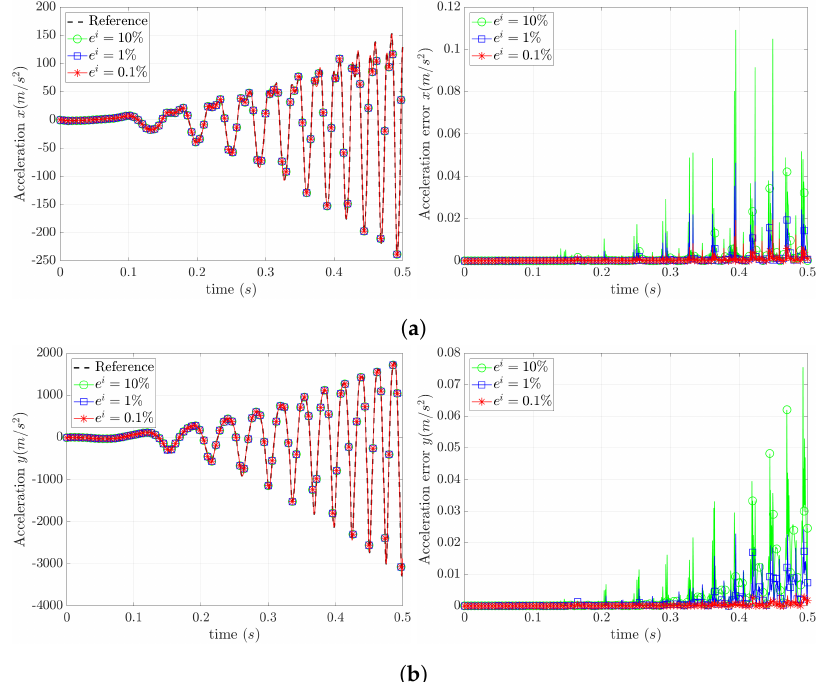
Figure 15. The time transient accelerations a x and a y of node A are compared for the different error tolerances e i = 10%, 1%, and 0.1% (left) and the errors (right). ( a ) Acceleration x of node A and its absolute error; ( b ) acceleration y of node A and its absolute